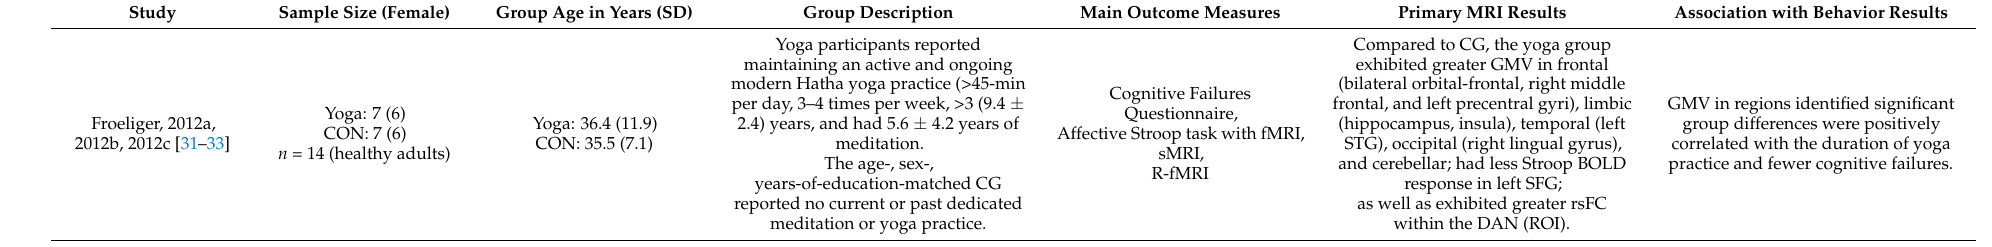
Table 1. Summary of included cross-sectional